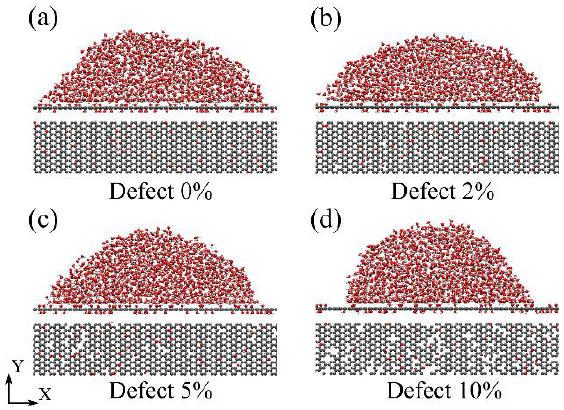
Figure 1. Simulation snapshots of a droplet on the graphene oxide (GO) surface, with various surface vacancy defect concentrations; ( a – d ) are the 0%, 2%, 5%, and 10% vacancy defect concentrations, respectively.